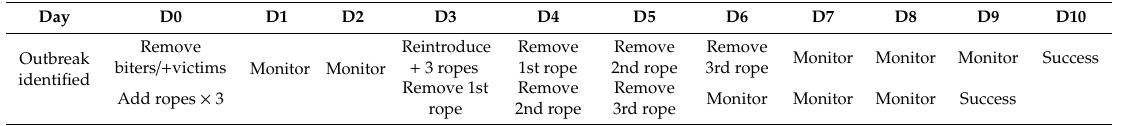
Table 1. Schematic process of a successful one-step